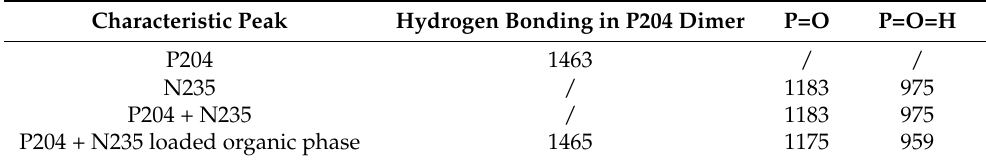
Figure 10. Infrared spectra of N235, P204, N235 + P204, and the loaded organic phase. Table 5. Characteristic frequencies of infrared spectra of N235, P204, N235 + P204, and the extraction phase.